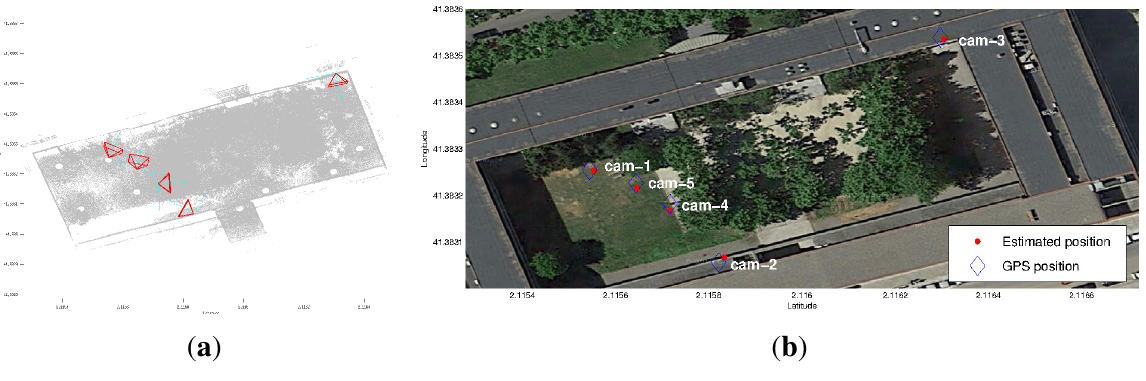
Figure 12. Camera localization for the FME scenario. ( a ) Camera viewpoint estimates; and ( b ) a comparison between GPS measures (blue squares) and our method (red points).